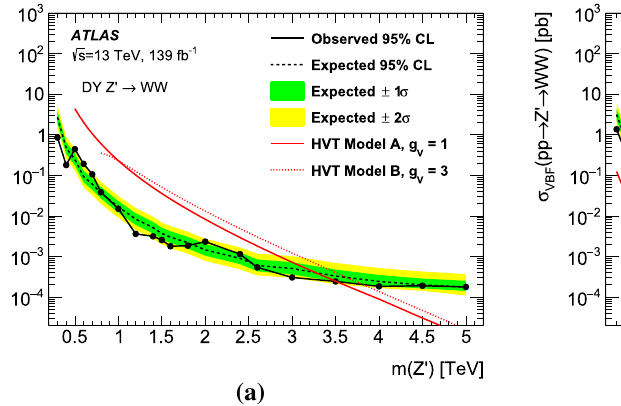
for the DY process and from 1.36 (3.15) pb at 300 GeV